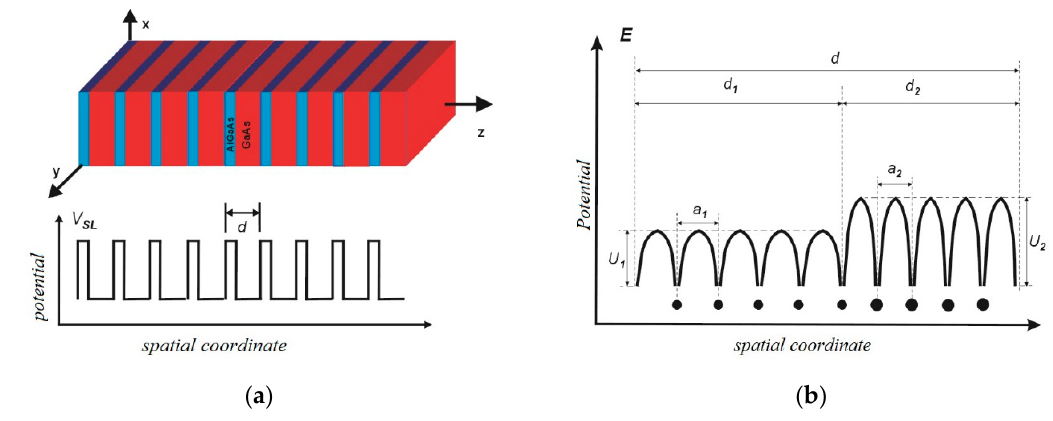
Figure 1. A part of a superlattice structure made as the system of two semiconductor layers: ( a ) the periodic potential of d period that arises in the material as a result of semiconductor layers modulation arrangement; ( b ) the periodic potential derived from the crystal lattice atoms of the superlattice.